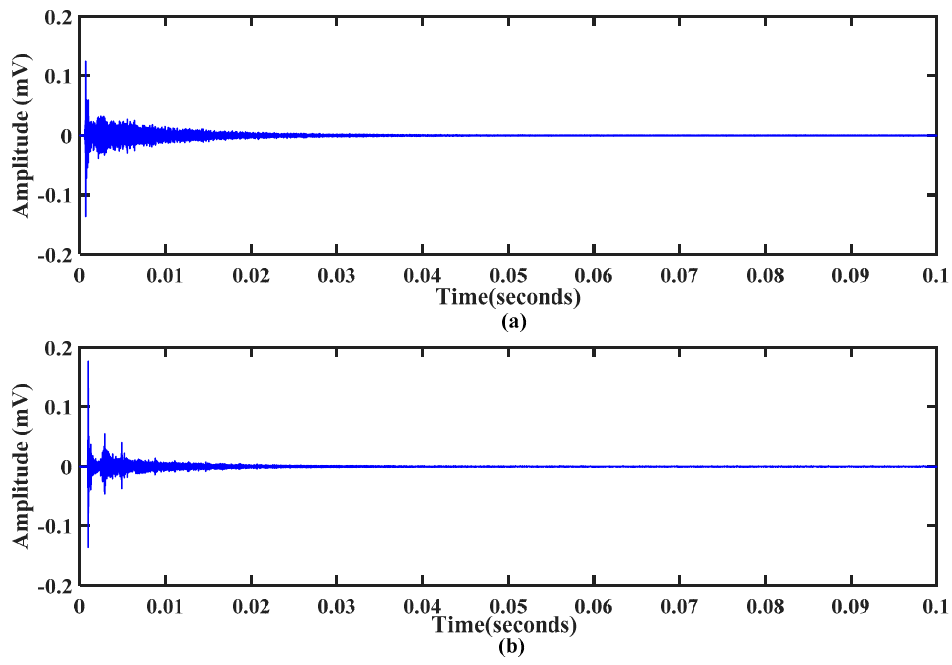
Figure 7. ( a ) Normal acoustic emission signals from the spherical tank; ( b ) Acoustic emission signals from the spherical tank with a 3 mm pinhole crack.